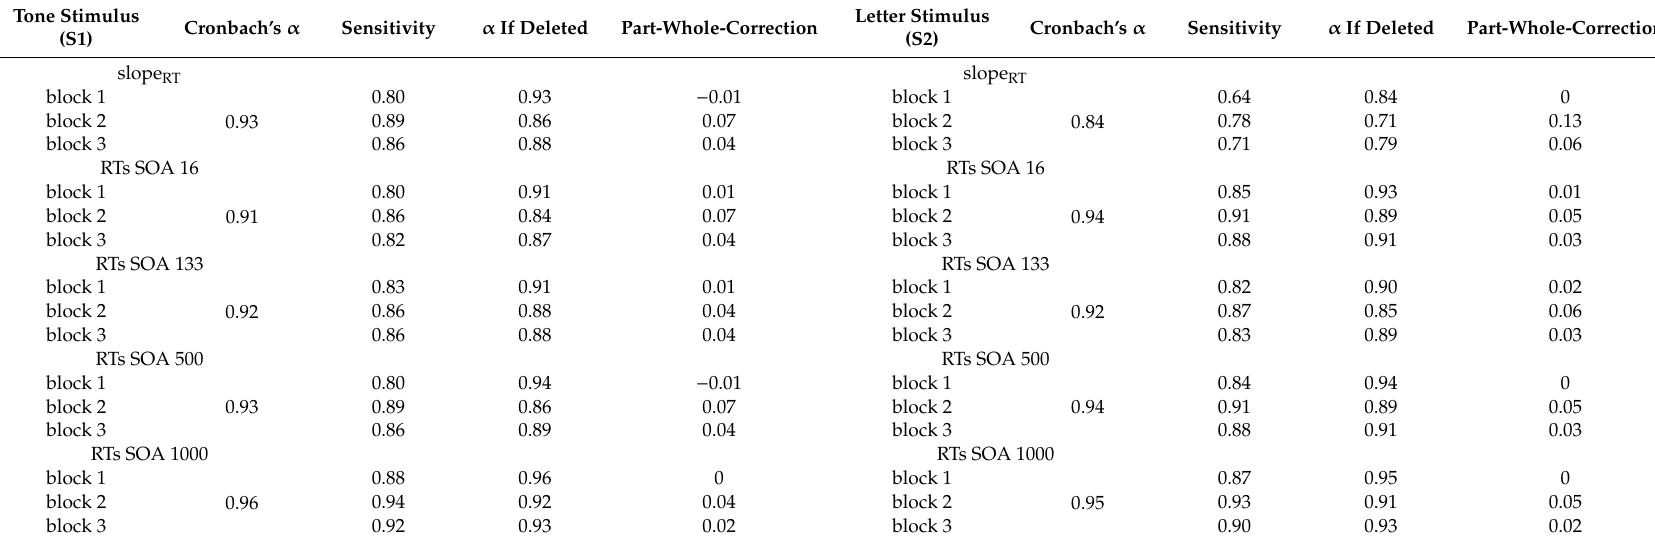
Table 3. Cronbach’s α reliability analysis for the slope RT and RTs in each of the di ff erent stimulus-onset asynchrony (SOA) conditions and